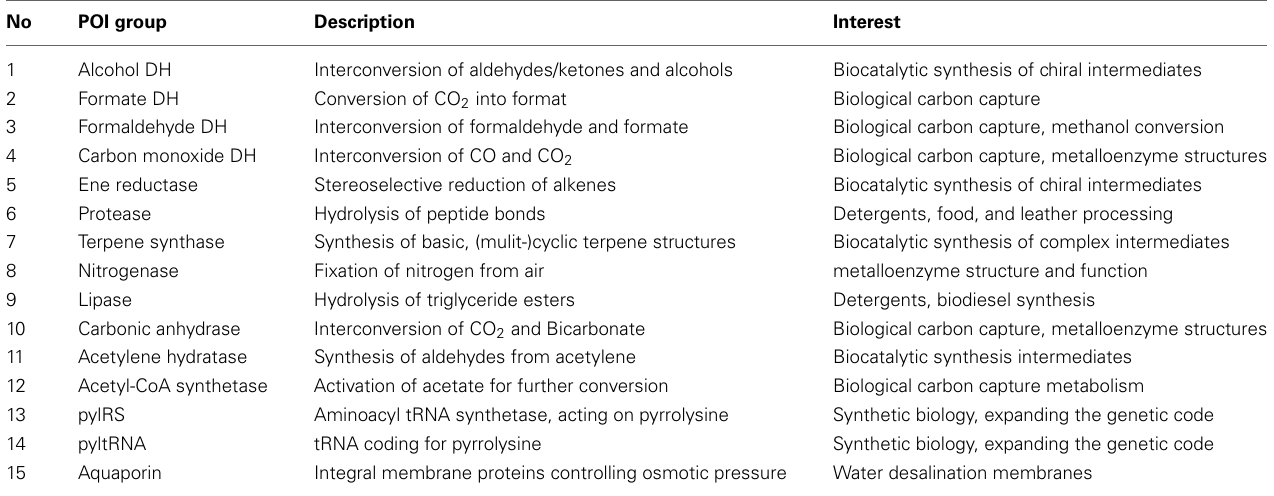
Table 2 | List of proteins of interest (POIs), which were selected for this